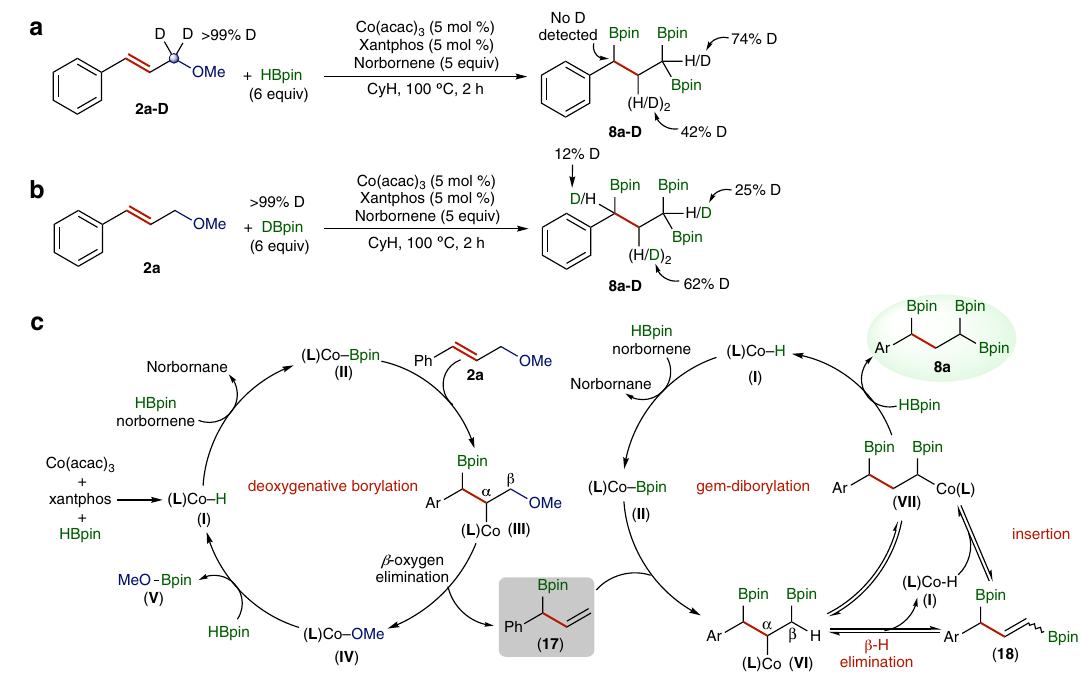
Fig. 4 Mechanistic studies. a The reaction of 2a-D with HBpin. b The reaction of 1a with DBpin. c The proposed catalytic pathways for this cobalt-catalyzed deoxygenative triborylation